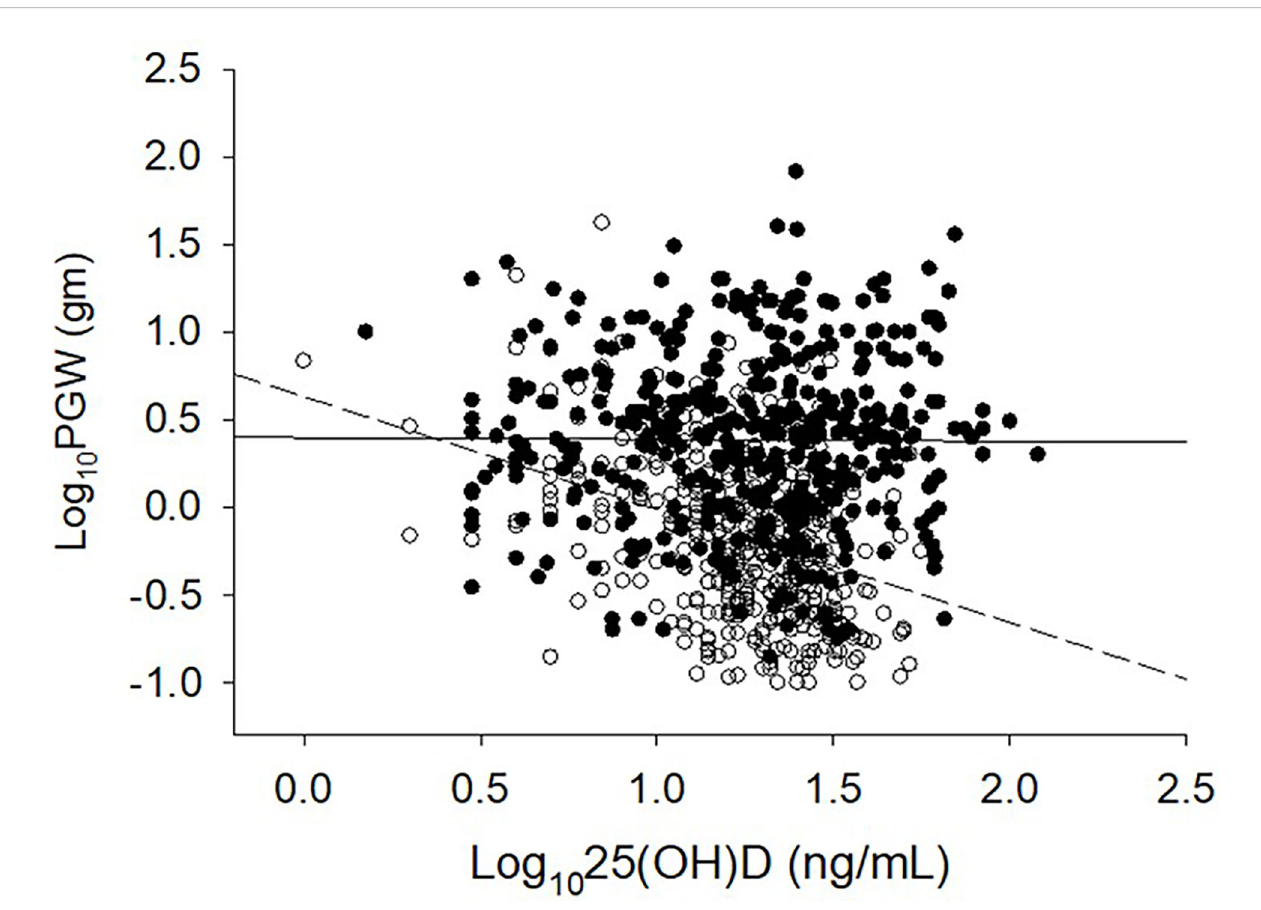
FIGURE 2 Relationship between serum 25-hydroxyvitamin D level and parathyroid adenoma weight in 2 large secularly diverse cohorts. Detroit Cohort: Open Circles and Dashed line (n=429). Indian Cohort: Closed Circles and Solid line (n=426). Data was log transformed because of the non-normal distribution of both variables. Note the lack of inverse relationship in and an upward shift of the Indian PHPT